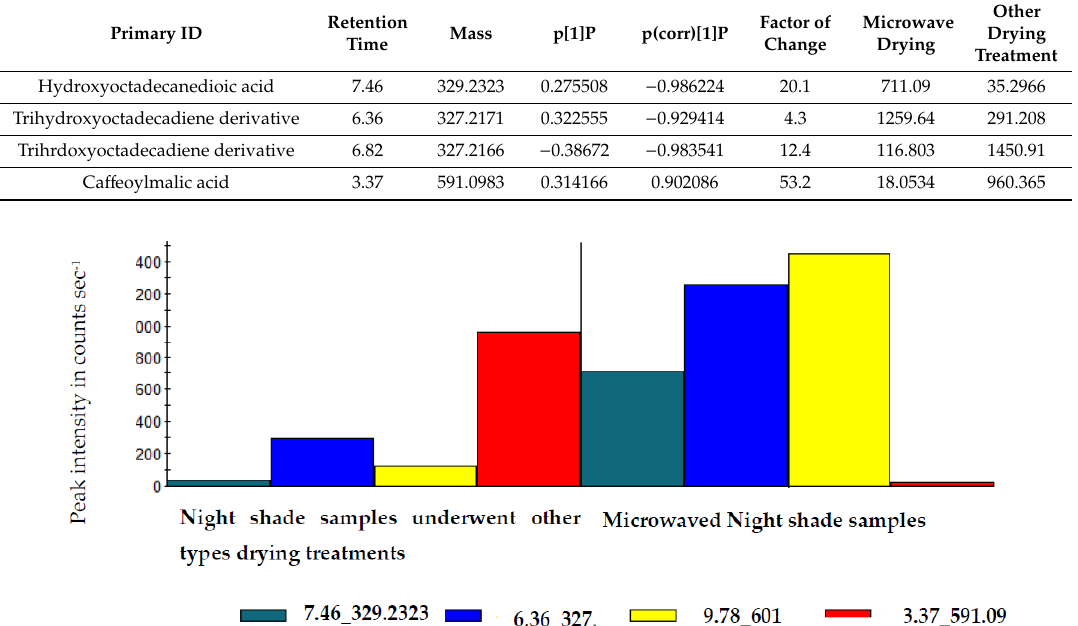
Figure 3. Histogram illustrating quantitative differentiation of biomarkers, between microwave drying and other drying treatments (traditional sun, solar, oven and freeze-drying) of Nightshade leaves.